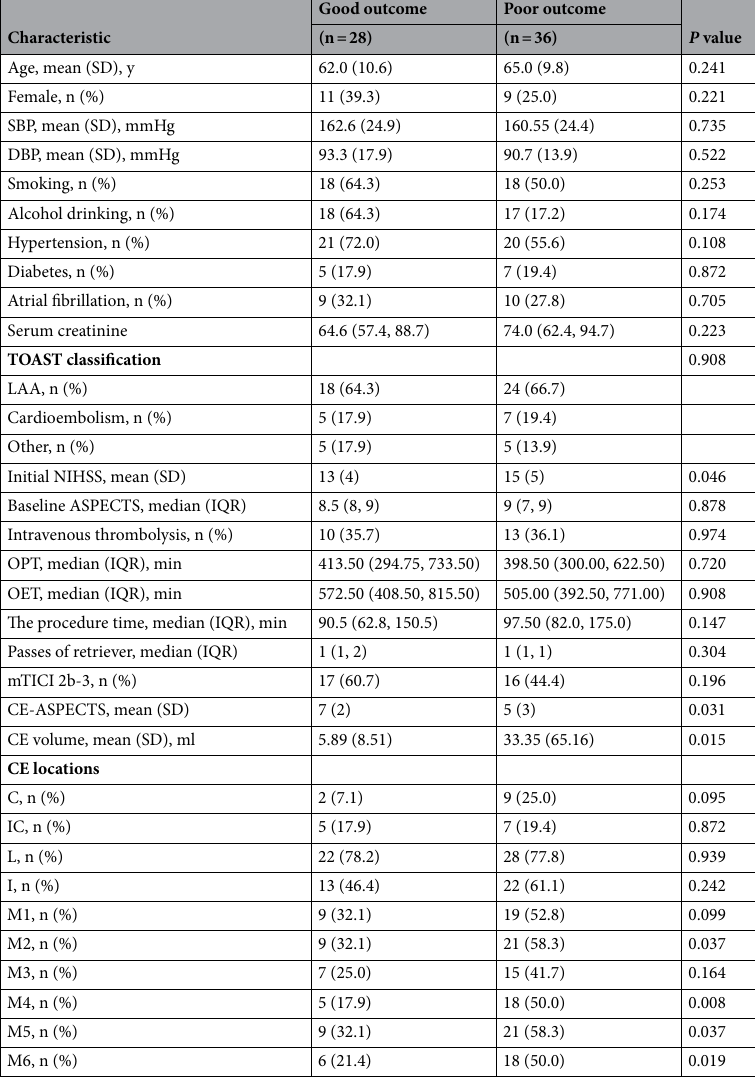
Table 1. Baseline characteristics of 64 patients. SBP systolic blood pressure, DBP diastolic blood pressure, LAA large artery atherosclerosis, SD standard deviation, NIHSS National Institutes of Health Stroke Scale, ASPECTS Alberta stroke program early computed tomography score, IQR interquartile range, OPT onset-to- procedure time, OET onset to the end of EVT time, mTICI modified Thrombolysis in Cerebral Infarction, CE contrast enhancement, C caudate nucleus, L lentiform, IC internal capsule, I insular